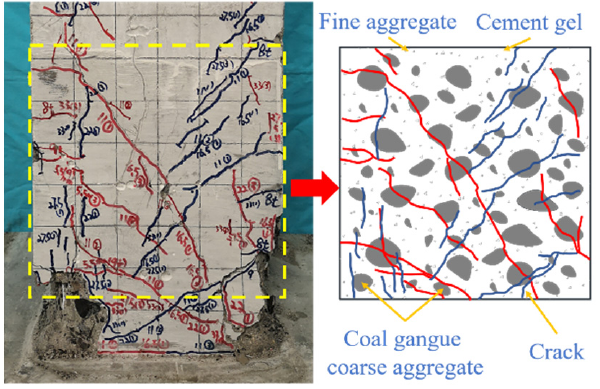
Figure 9. Crack interface of CGC specimen.